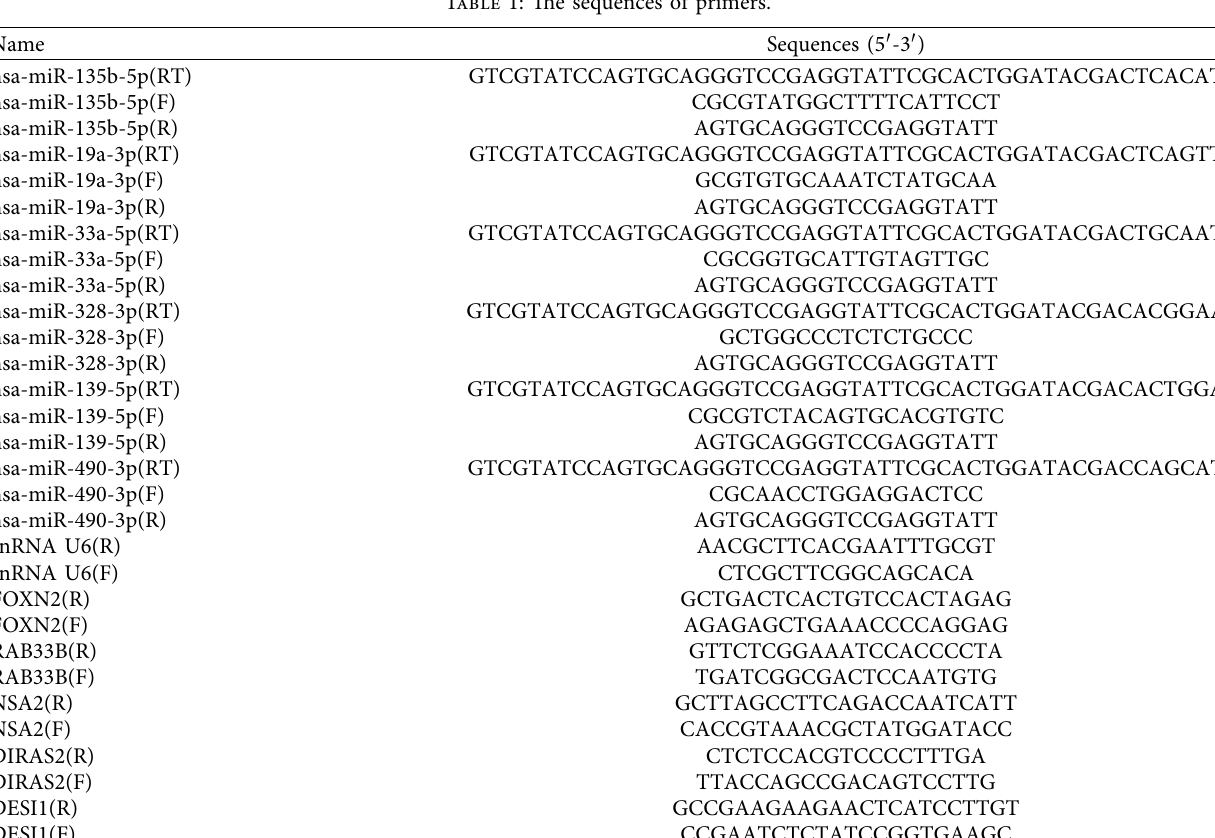
Figure 1: Flowchart of this Table 1: Te sequences of primers.